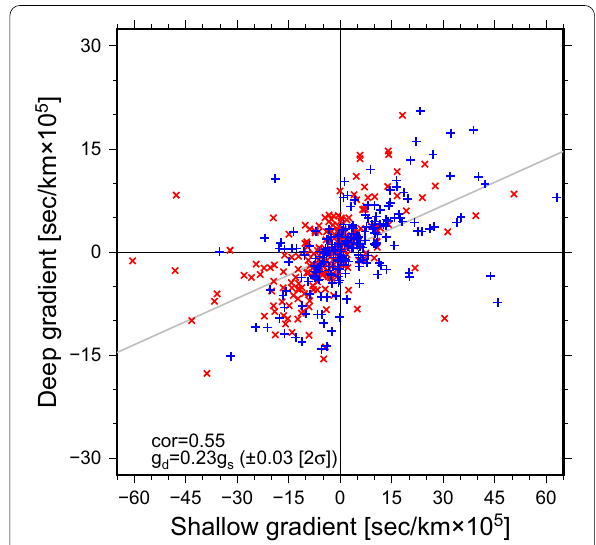
Fig. 6 Scatter diagram of the shallow gradients and the deep gradients for the six sites. The shallow gradients were estimated using Method-3, and the deep gradients were estimated using Method-2. Red and blue symbols represent EW and NS components. The solid line represents the linear regression line. The regression equation and the correlation coefficient are